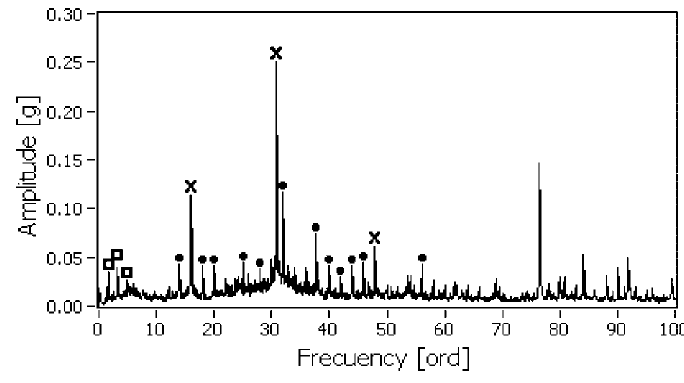
Fig. 22. Order Spectrum. Key: x = harmonics of GMF1, (cid:3) = harmonics of GMF2, and • = harmonics of 2